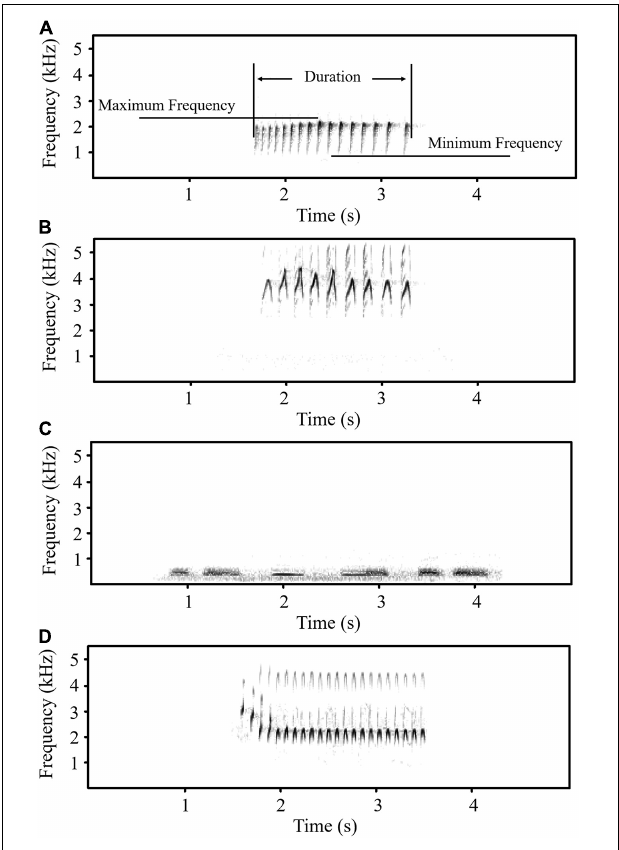
FIGURE 1 | Spectrogram of female common cuckoo “bubbling” call (A) , common kestrel call (B) , oriental turtle dove call (C) , and little grebe call (D) .